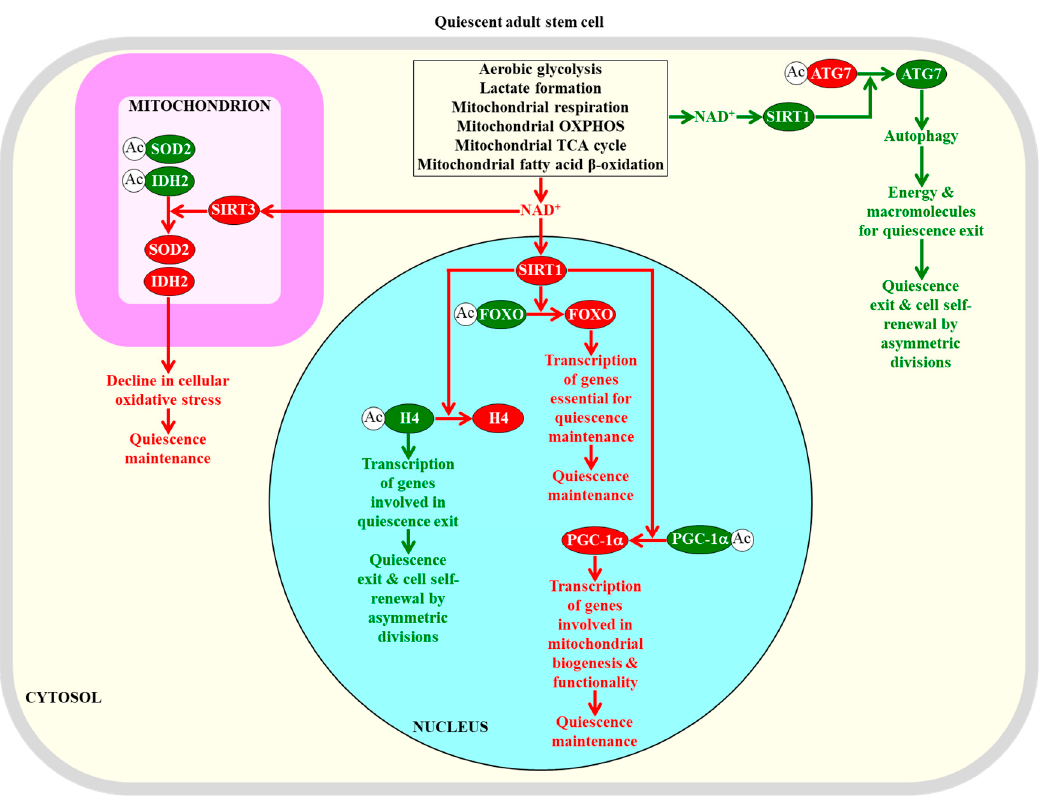
Figure 3. NAD + concentration within adult stem cells defines how efficiently these cells can maintain quiescence or self-renew by undergoing asymmetric divisions. The NAD + -activated sirtuin SIRT1 in the nucleus is required for the maintenance of quiescence in adult stem cells, because this SIRT1 deacetylates histone H4 and the transcriptional factors FOXO and PGC-1 α . The NAD + -activated sirtuin SIRT3 in mitochondria is essential for quiescence maintenance by adult stem cells, because this SIRT3 deacetylates and activates superoxide dismutase SOD2 and isocitrate dehydrogenase IDH2, both of which weaken cellular oxidative stress. The NAD + -activated sirtuin SIRT1 in the cytosol is required for the transition from quiescence to self-renewal by asymmetric divisions, because this SIRT1 deacetylates and activates the autophagy-related protein ATG7 to promote autophagy, which provides the energy and macromolecules required for such transitions. Proteins, metabolites, and processes whose activities, concentrations, and rates must be increased to maintain the quiescence of adult stem cells are displayed in red. Proteins, metabolites, and processes whose activities, concentrations, and rates must be increased to promote the self-renewal of adult stem cells by asymmetric divisions are displayed in green. The red arrows define processes whose intensities must be increased to maintain the quiescence of adult stem cells. The green arrows define processes whose intensities must be decreased to maintain the quiescence of adult stem cells. See text for more details. Abbreviations: Ac, acetyl group; ATG7, the autophagy-related protein 7; FOXO, transcriptional factors of the Forkhead family; H4, histone H4; IDH2, mitochondrial isocitrate dehydrogenase 2; OXPHOS, oxidative phosphorylation; PGC-1 α , peroxisome proliferator-activated receptor-gamma coactivator 1 α ; SIRT1 and SIRT3, NAD + -dependent protein deacetylases sirtuin 1 and sirtuin 3 (respectively); SOD2, mitochondrial manganese superoxide dismutase. SIRT3, a mitochondrial form of the NAD + -dependent sirtuins, is essential for the maintenance of quiescence in adult hematopoietic stem cells [46,244,245]. Since NAD + -stimulated SIRT3 deacetylates